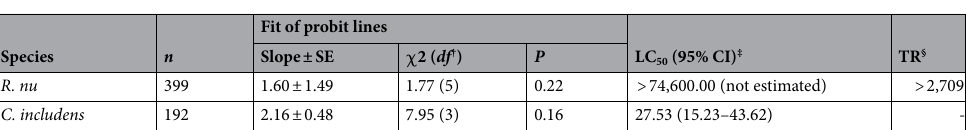
Table 2. Concentration-mortality response (ng Cry1Ac/cm 2 ) of C. includens and R. nu neonates exposed to purified Cry1Ac protein in diet-overlay bioassay. † df = degrees of freedom. ‡ LD 50 and 95% confidence